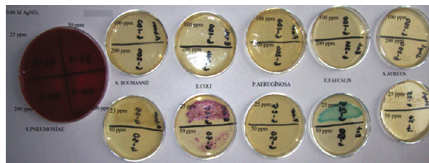
Figure 8: Antibacterial activity of chitosan-Ag nanoparticle materi- als synthesized with 0.02M AgNO 3 .